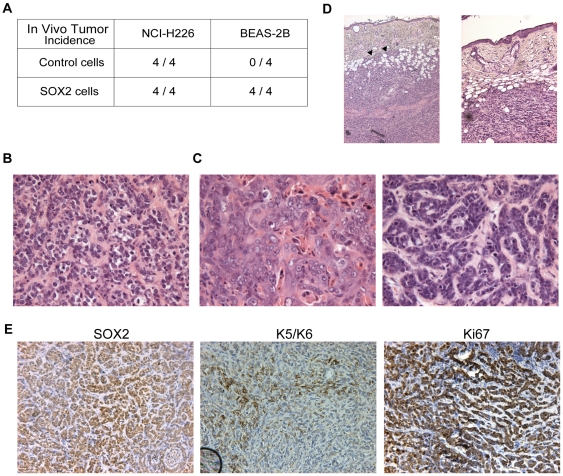
Consequences of Sox2 over-expression in vivo.
A. Tumor incidence upon subcutaneous implantation of human lung squamous control- and SOX2-transduced cell lines in nude mice. For each cell line, the number of tumors that developed is represented with respect to the number of injections for each cell type (control or SOX2-transduced, n = 4 injected animals each). Tumor incidence is unchanged for the NCI-H226 highly tumorigenic cell line, whereas BEAS-2B cells become tumorigenic upon Sox2 over-expression. B. Hematoxylin and Eosin (H&E) staining of a representative area of a BEAS-2B-Sox2 subcutaneous tumor (magnification = 100×). A majority of the tumor area (around 80%) has typical traits of poorly differentiated basaloid variants of squamous cell carcinoma. C. H&E staining of representative areas of the same BEAS-2B-Sox2 subcutaneous tumor as in panel B (magnification = 100×). Around 20% of the tumor area has typical traits of poorly to moderately differentiated squamous cell carcinoma, with individual cell keratinization. D. H&E staining of one BEAS-2B-Sox2 subcutaneous tumor (magnification = 50×). In this case, local tumor cell invasion into the dermis was observed (arrowheads). E. Immunohistochemistry for SOX2, Keratins 5/6 and Ki67 (left, middle and right panels, respectively; magnifications = 200×). Tumors homogeneously express SOX2 and Ki67 and heterogeneously express Keratins 5/6, which are squamous cell differentiation markers.